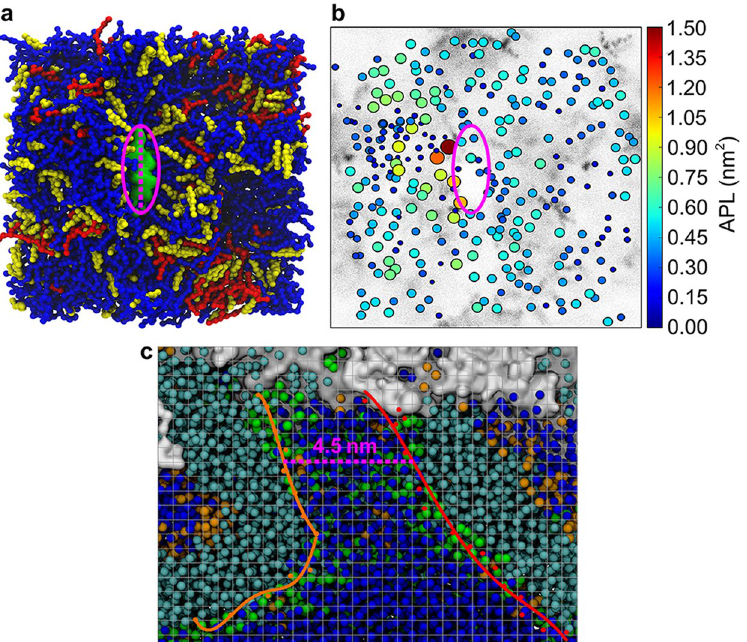
Figure 5. Properties of the membrane that lead to membrane poration. ( a ) Top view of the IN membrane at 100 µ s. DPPC, DLiPC and CHOL are shown as CPK models in red, blue and yellow, respectively. The green surface and magenta oval are used to highlight the pore area in the membrane. The dashed line shows the diameter of the pore. ( b ) Scatter plot representing the positions of the lipid head beads of the outer and inner layers of the membrane. The size and color of each point in the plots correspond with the APLs of each head bead (see the color scale bar). The cloud in the background presents the density of CHOL. ( c ) Side view of the IN membrane. The atoms in the hydrophobic tails of the membrane are shown as cyan balls. The head groups of the lipid molecules in the outer and inner layers are shown in orange and green, respectively. The cluster of kB1 molecules is shown via a surface model in white. The water beads are shown as blue balls. The snapshot is overlaid by a scatter plot representing the position of lipid head beads that form the edge of the volcano- like channel. The plots are fitted with lines (shown with orange and red colors) to highlight the boundary of the channel. The average distance from the orange line to the red line is 4.5 nm. The size of each grid space is 0.5 × 0.5